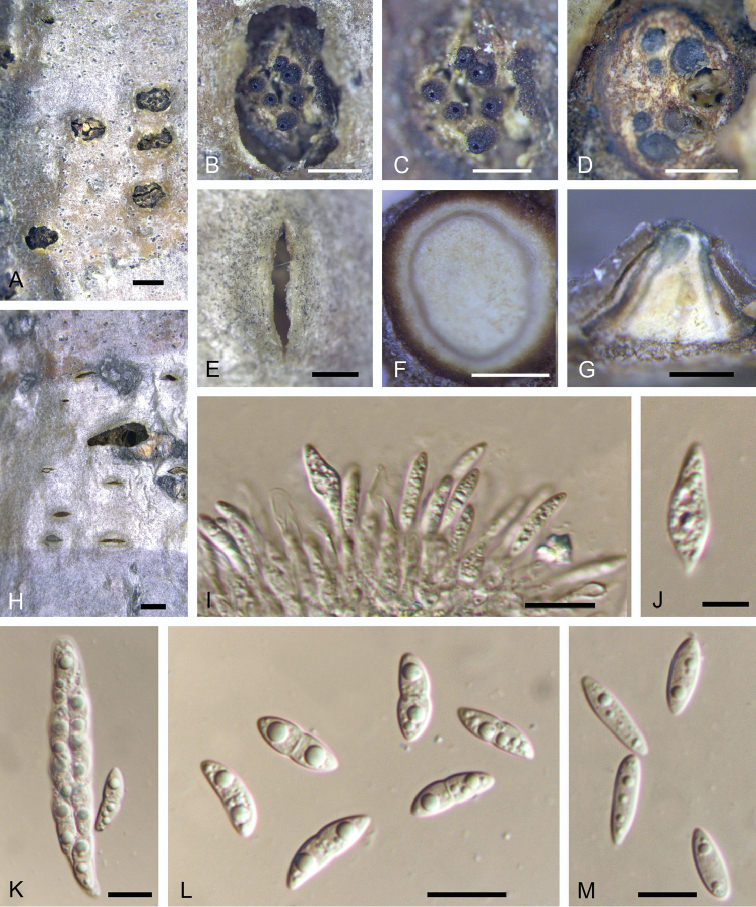
Morphology of Dendrostomaquercus from Quercus sp. (BJFC-S1547). A–C Habit of psedostromata on branches D Transverse section of pseudostroma E, H Habit of conidiomata on branches F Transverse section of conidioma G Longitudinal section through conidioma I Conidiogenous cells producing dimorphic conidia J Secondary conidia K Asci and ascospores L Ascospores M Primary conidia. Scale bars: 1 mm (A, H); 0.5 mm (B–G); 10 μm (I, K–M); 5 μm (J).